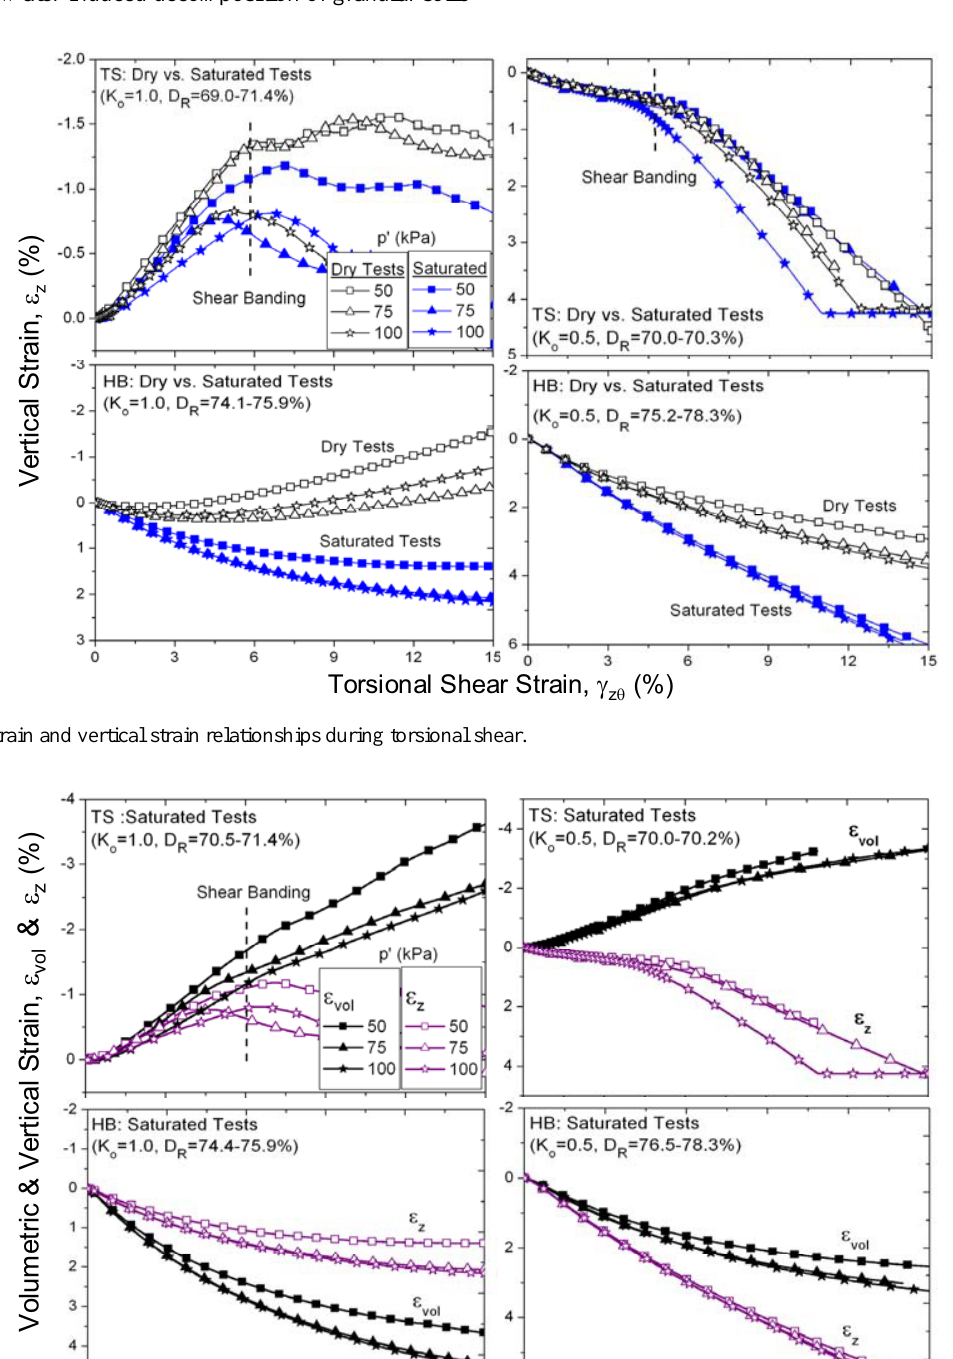
Fig. 15. Comparison between volumetric and vertical strains during torsional shear.